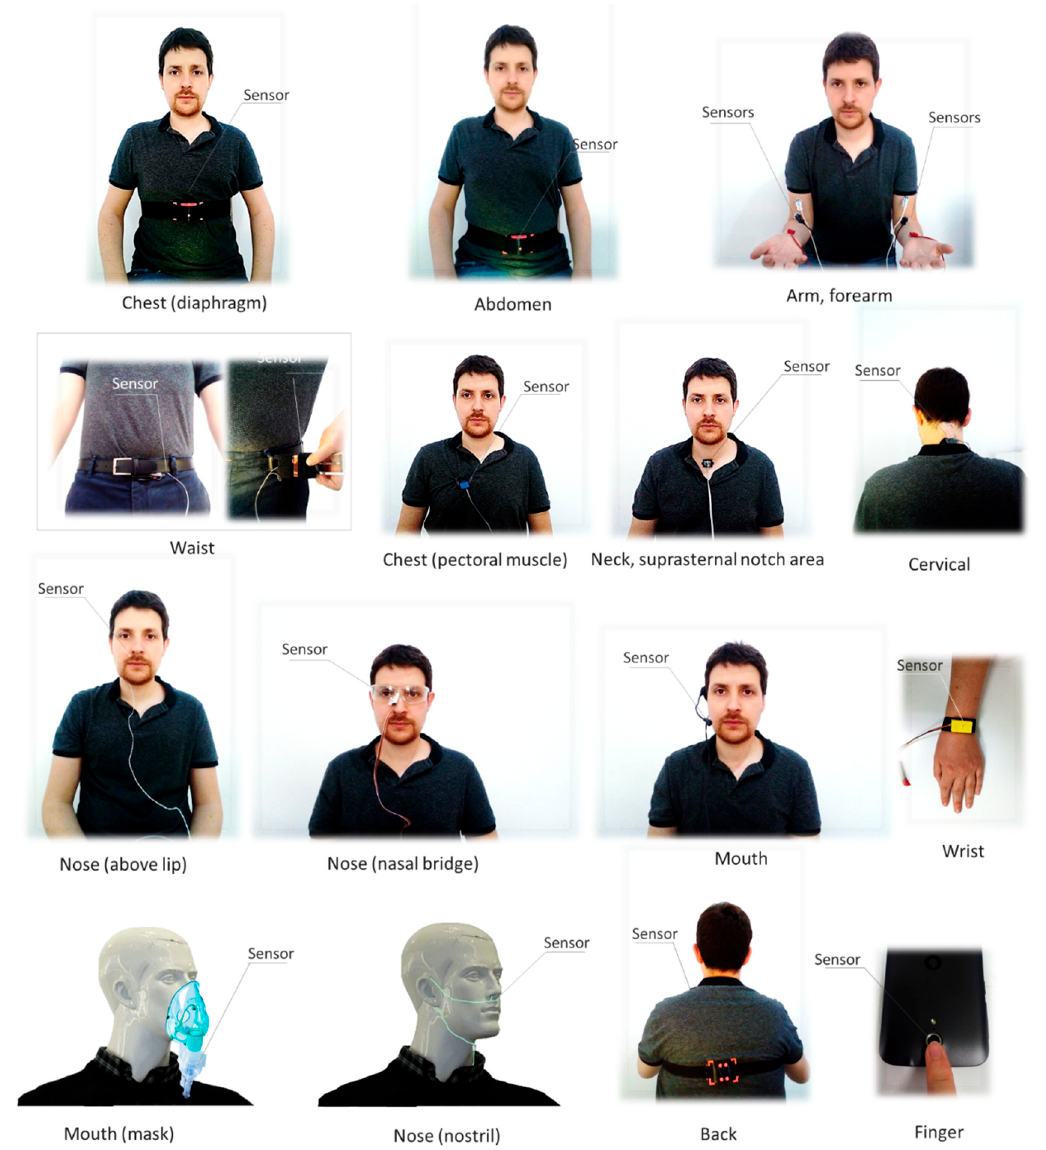
Figure 5. Most common sensor locations for respiration monitoring. The sensors shown are for contextualization purposes.